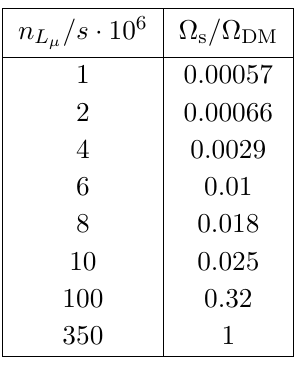
Table 2 . Fraction of the relic DM abundance for the initial lepton asymmetries used in (cid:12)gures 1{3 and in the appendix. We show only the abundance for the case where (cid:0) spline is